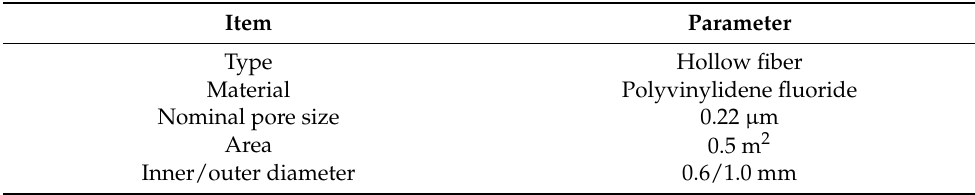
Table 1. Parameters of membrane module.